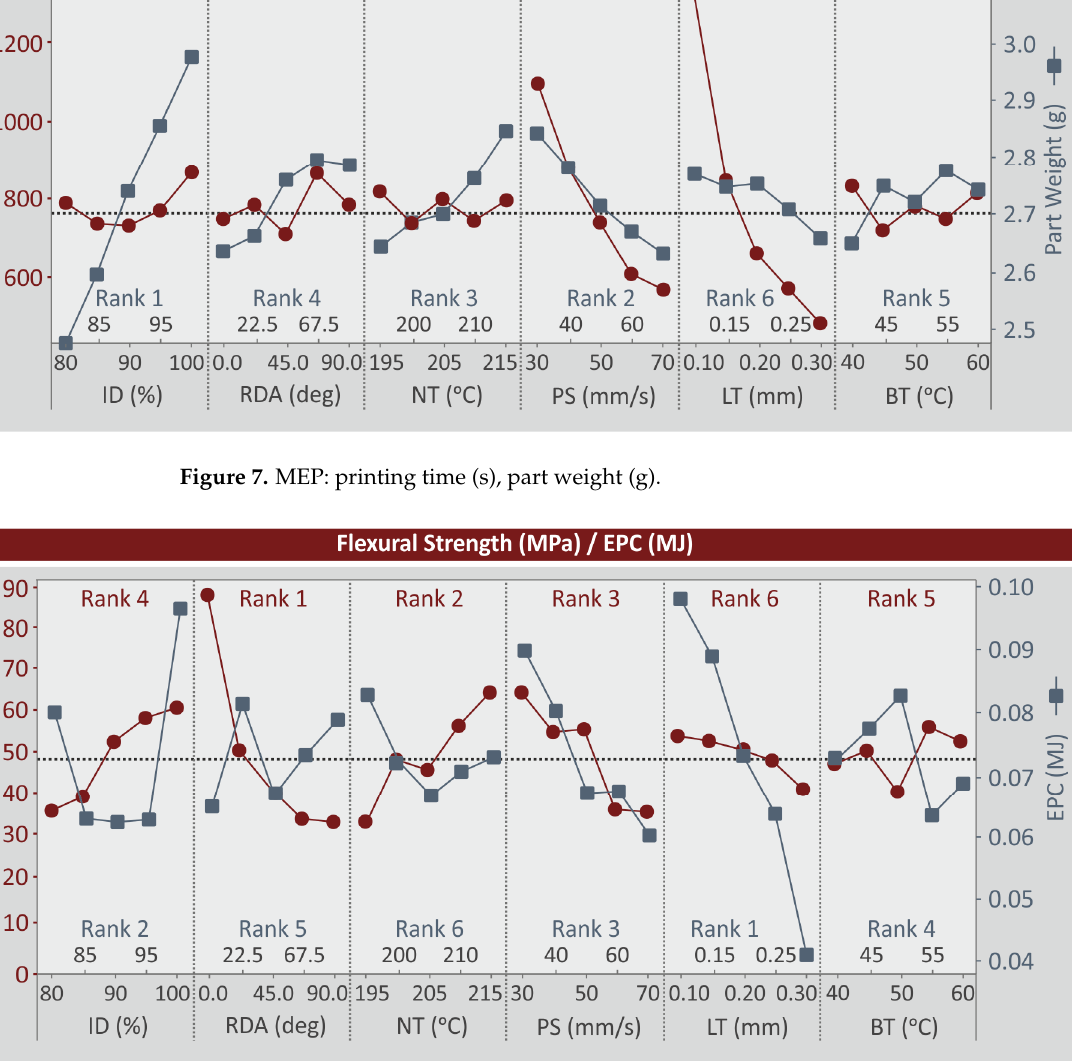
Figure 9. Interaction plots: flexural strength (MPa), EPC (MJ).